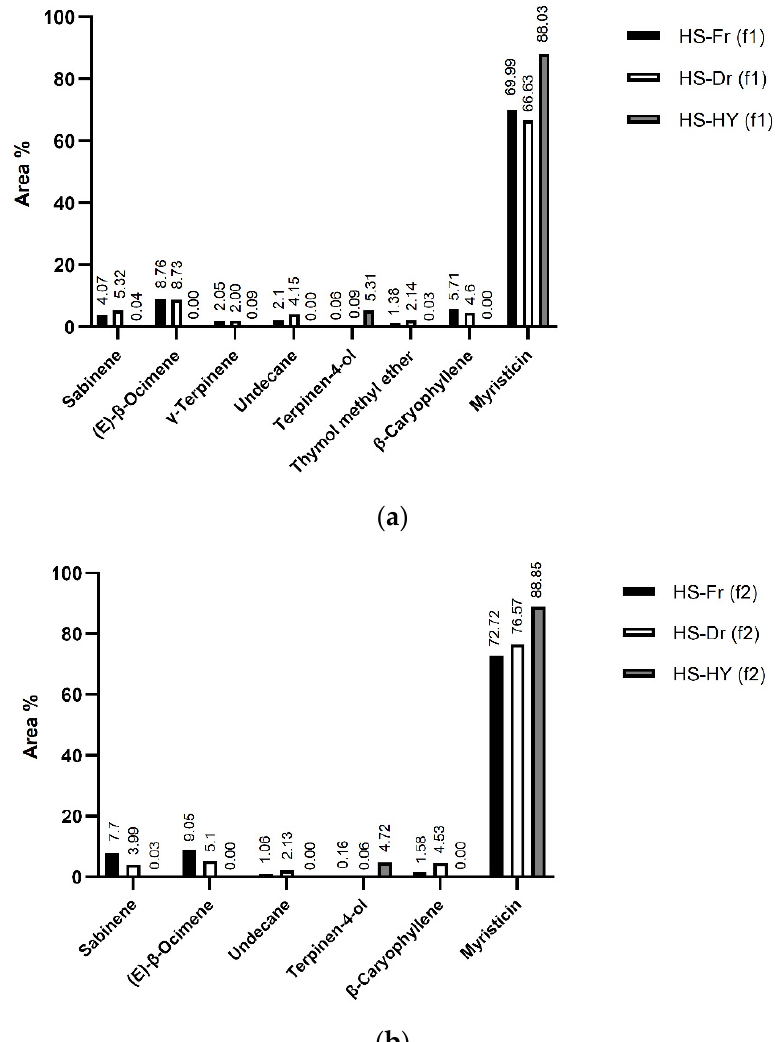
Figure 4. The most abundant compounds in the headspace composition (HS) of fresh (Fr) and air- dried (Dr) plant material and hydrosol (HY) on ( a ) divinylbenzene/carboxene/polydimethylsiloxane fibre (f1) and ( b ) polydimethylsiloxane/divinylbenzene fibre (f2).